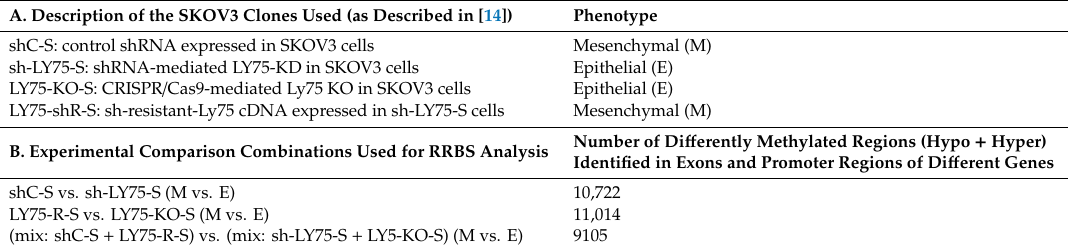
Table 1. Reduced representation bisulfite sequencing (RRBS) analysis of altered DNA methylation patterns upon Ly75-mediated epithelial–mesenchymal transition (EMT) variations in SKOV3 cells. A. Description of the SKOV3 Clones Used (as Described in [14])